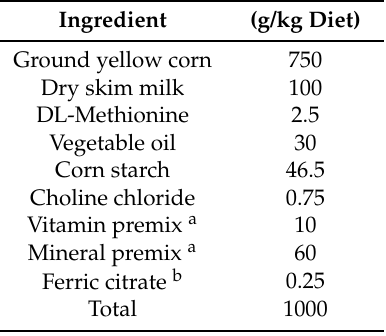
Table 1. Composition of Fe-inadequate experimental diet.